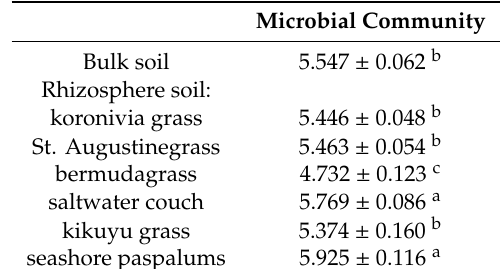
Table 3. Microbiome diversity in bulk soil and rhizosphere soils of perennial grasses. Diversity was indicated by Shannon index. Data are presented as mean ± standard error at p = 0.05. Within each column, means followed by the same letter were not significantly di ff erent, based on least significant di ff erence (LSD) at p =